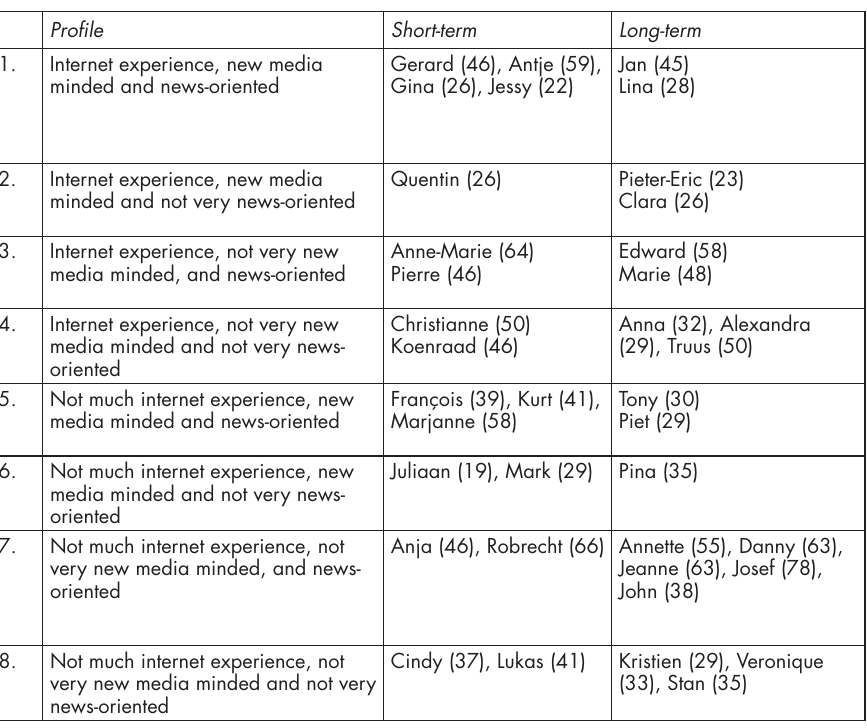
table 1 Cross-tabulation of the different news user profiles according to a maximum variation analysis (pseudonyms are used, age in brackets) The final sample included 38 participants, men and women from different socio- economic backgrounds, with a fairly even distribution among the participants. All were living in Flanders or Brussels and were between 20 and 72 years old. We chose to work with two groups, a short-term and a long-term